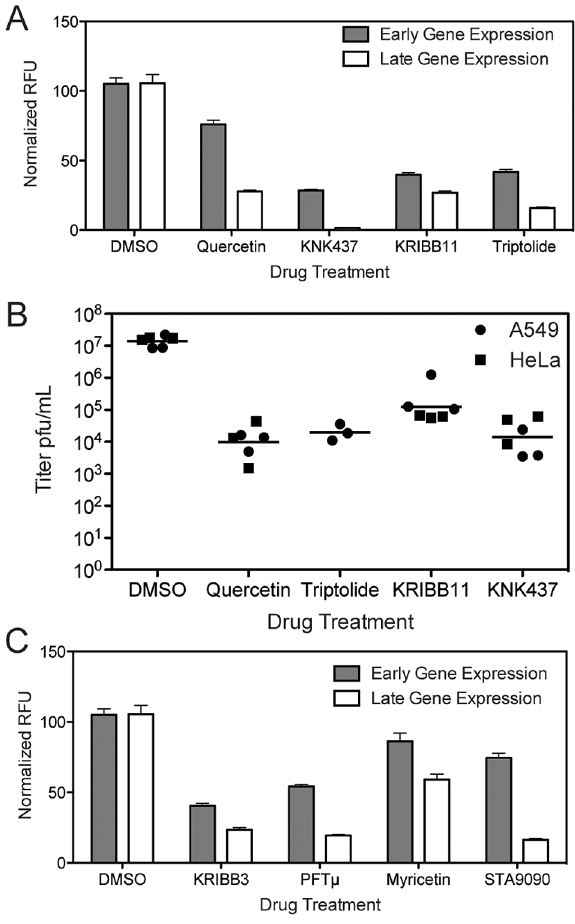
Figure 7. Inhibitors that target HSF1 or HSF1-transcribed genes block VACV infection. (A) Inhibitors targeting HSF1 activity block VACV gene expression in A549 cells. Cells treated with 1 m M Triptolide, 50 m M Quercetin, 50 m M KNK437 or 50 m M KRIBB11 were infected with VACV-LREV at MOI 1 for 16 hours. Cells were fixed and fluorescence read to measure early and late gene expression. Three independent experiments were completed in triplicate; this is a representative plot showing RFU normalized to DMSO control at 100% with standard error. (B) Inhibitors targeting HSF1 activity block VACV infection in A549 and HeLa cells. Cells were treated with compounds at same concentrations as (A), and infected with VACV for 24 hours. Virus was collected and titered by plaque assay. HSF1 inhibitors block viral titers by 2–3 logs. (C) Inhibitors targeting HSF1- transcribed HSPs block VACV gene expression in A549 cells. Cells treated with 1 m M STA9090, 50 m M KRIBB3, 50 m M PFT m and 100 m M Myricetin were infected with VACV-LREV at MOI 1 for 16 hours. Cells were fixed and fluorescence read to measure early and late gene expression. Three independent experiments were completed in triplicate; this is a representative plot showing RFU normalized to DMSO control at 100% with standard error.